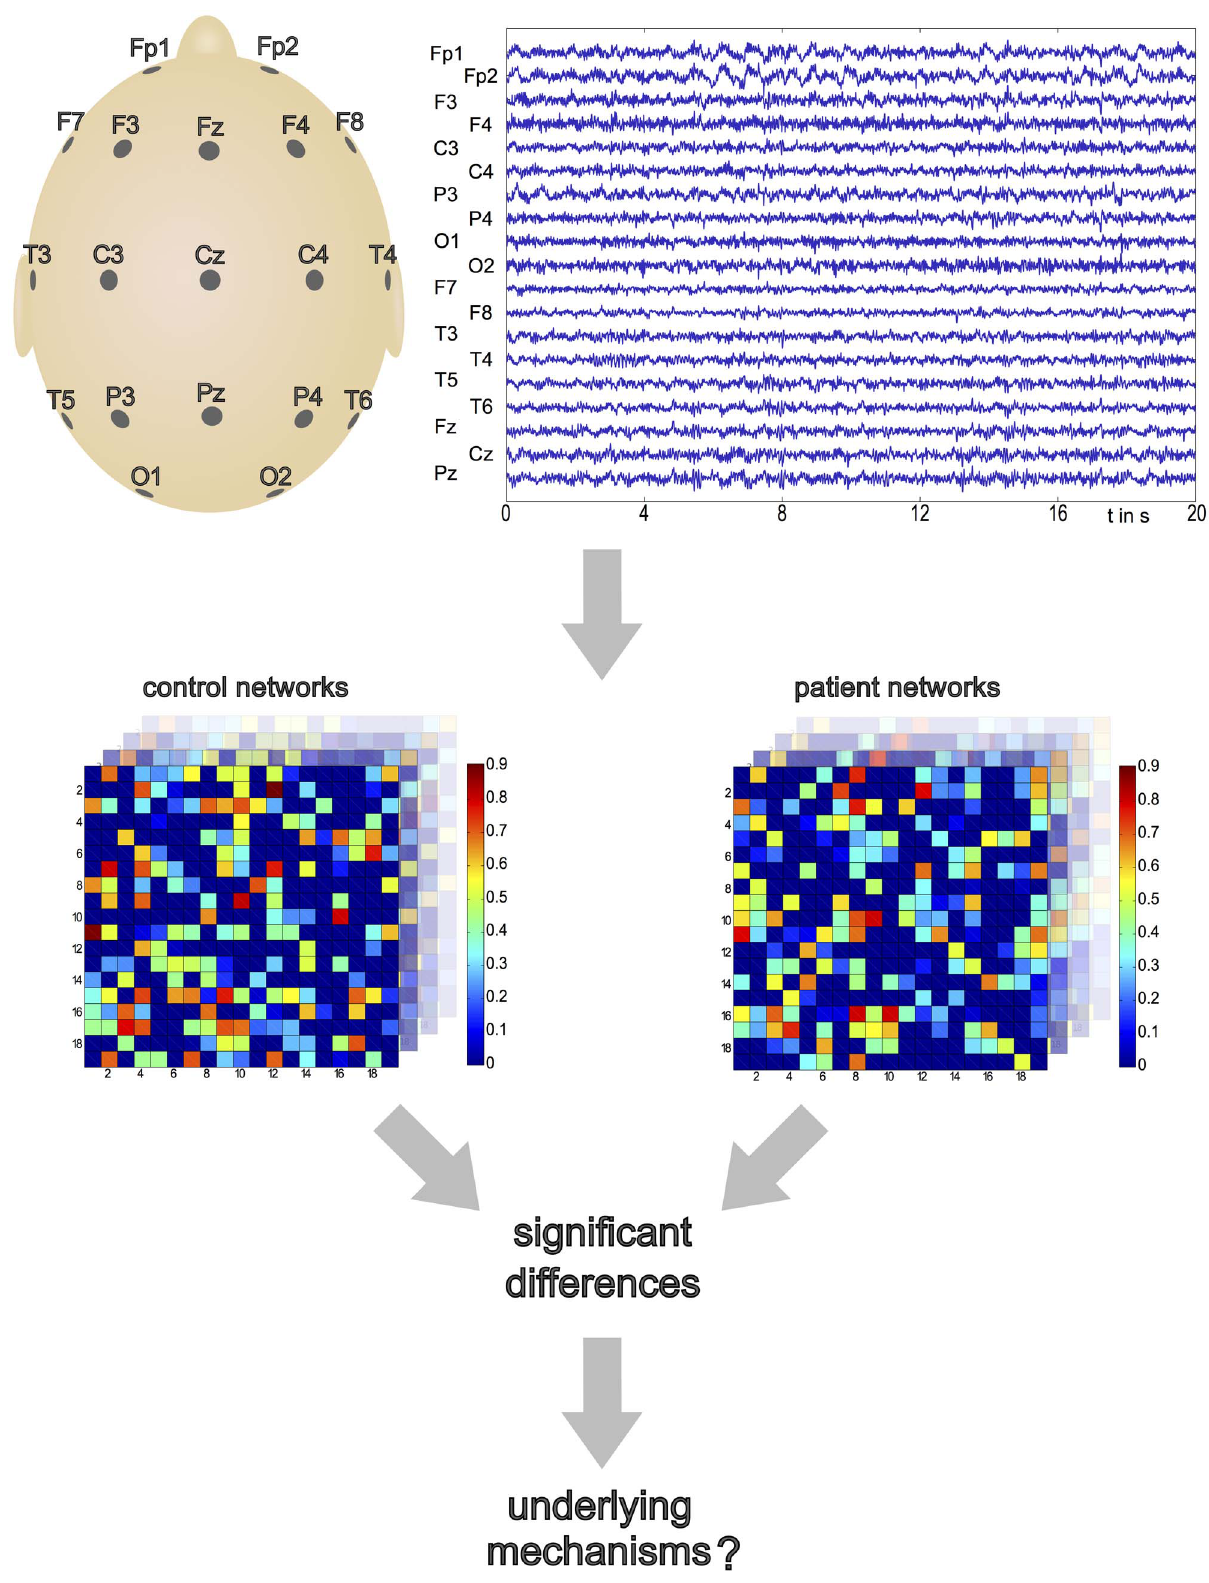
Figure 1. Motivation of our modeling approach. The Electroencephalogram (EEG) records electrical signals from electrodes placed on the scalp. There exist various methods to derive functional network structure from the recorded time series. The primary challenge is to identify (statistically) significant differences between the functional networks of subjects with a particular neurological disorder, and healthy controls. The second challenge is to identify the underlying mechanisms that lead to these changes in network structure, and how they affect the behavior of the model